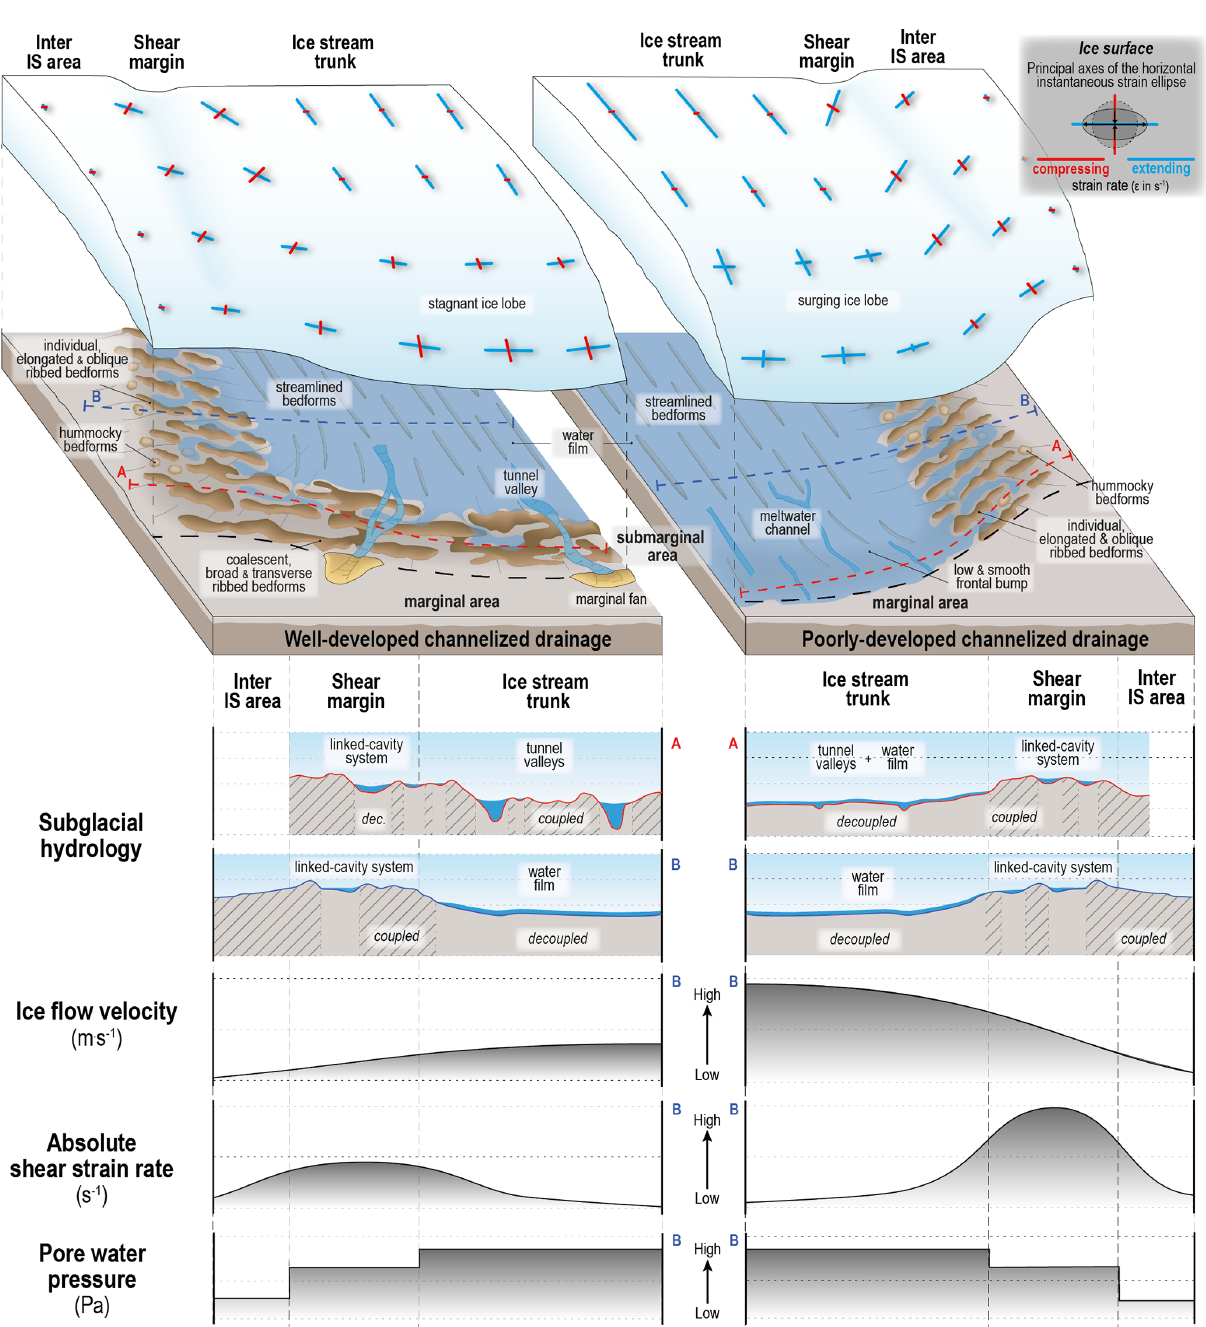
Figure 15. Conceptual model summarizing our observations and interpretations and the proposed role of hydrology, ice velocity and super- ficial ice strain in generating the observed landforms and their spatial distribution. This is for a terrestrial ice stream context characterized by either well-developed or poorly developed channelized drainage below the lobe frontal